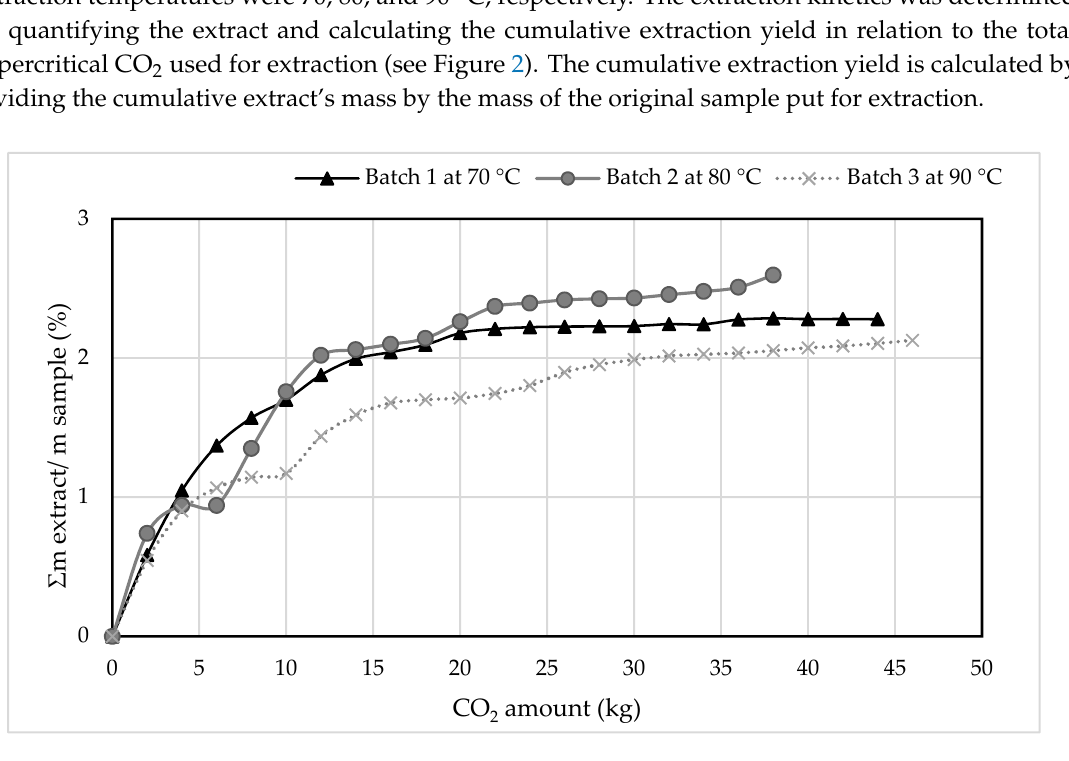
Figure 2. A Comparison of the cumulative SCE rates for each of the test batches in relation to the amount of the used SC-CO 2